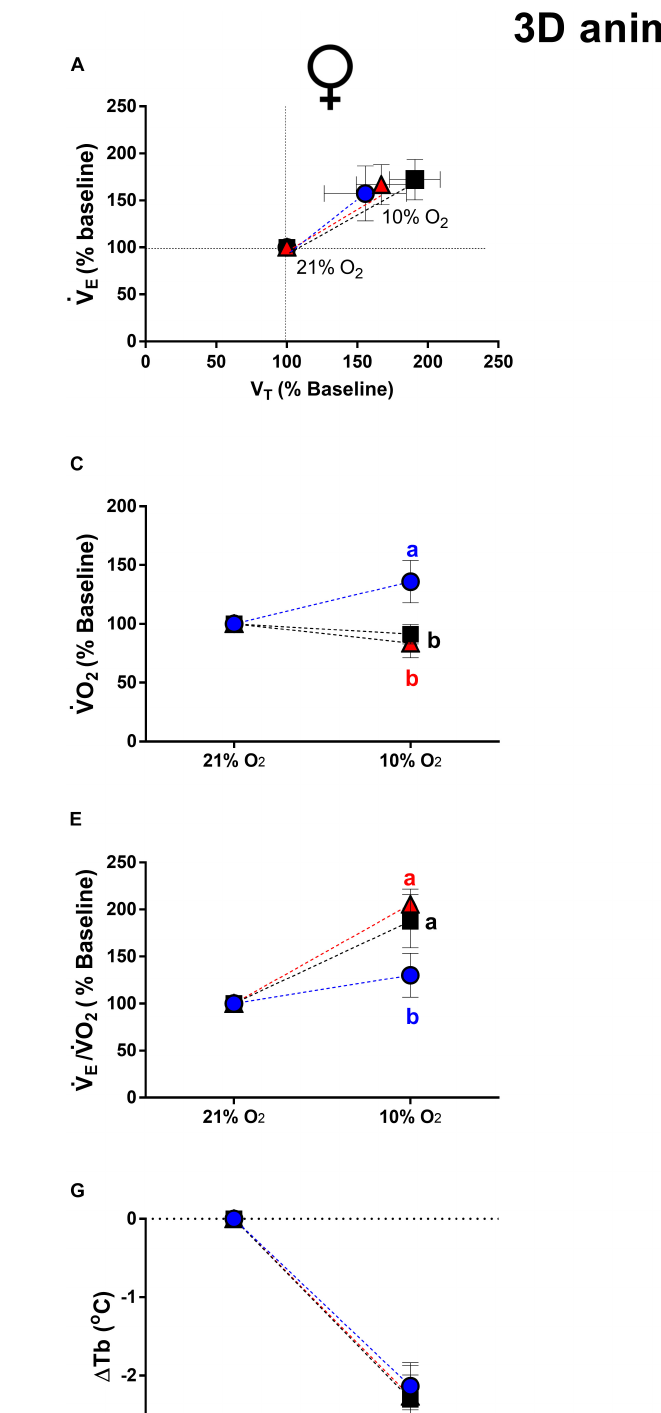
Frontiers in Physiology |